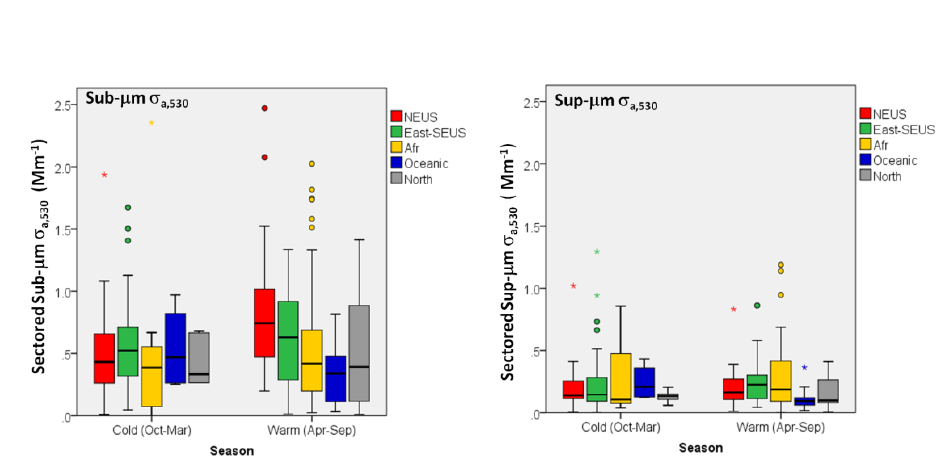
, (b) super-µm nss SO 2 − , (c) sectored sub-µm σ s , 530 , 4 4